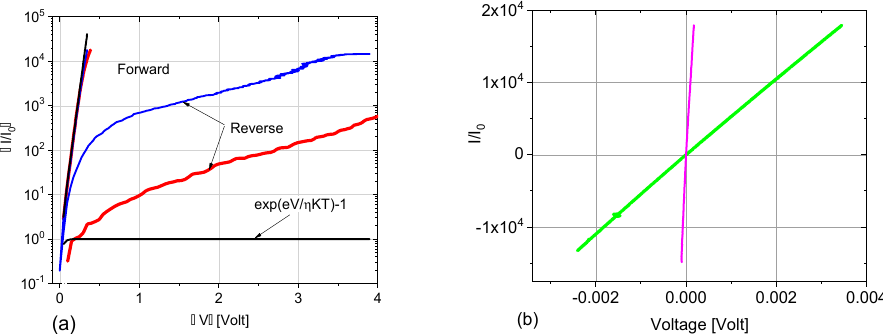
Figure 5. The I–V curves of p+-type sample: ( a ) two-probe; ( b ) four-probe. The red color corresponds to the nanograting area recorded using two probes; the blue refers to the plain area recorded using two probes; the green color refers to the nanograting area recorded using four probes; and the violet refers to the plain area recorded using four probes. Colors correspond to voltage and current terminals labels in Figure 2. Shockley equation fitting curve (for η = 1.25) is shown in black color. Forward current of p + -p(v)-M junction (Figure 5a) is not affected by the NG. Forward currents of p + -p(v)-M junction and corresponding reference junction fit well with the Shock- ley expression, with close ideality factor values ( η = 1.25). Current-voltage dependence of p + -p(v) junction (green curve in Figure 5b) indicates that p + -p(v) junction is ohmic type with a resistance higher than the substrate resistance (violet curve in Figure 5b). However, p + -p(v) junction has much lower resistance with respect to the reverse biased p + -p(v)-M junction (see voltage scales in Figure 5a,b). Reverse currents of p + -p(v)-M junction (red curve) are dramatically lower with respect to reference junction. Reduction is as large